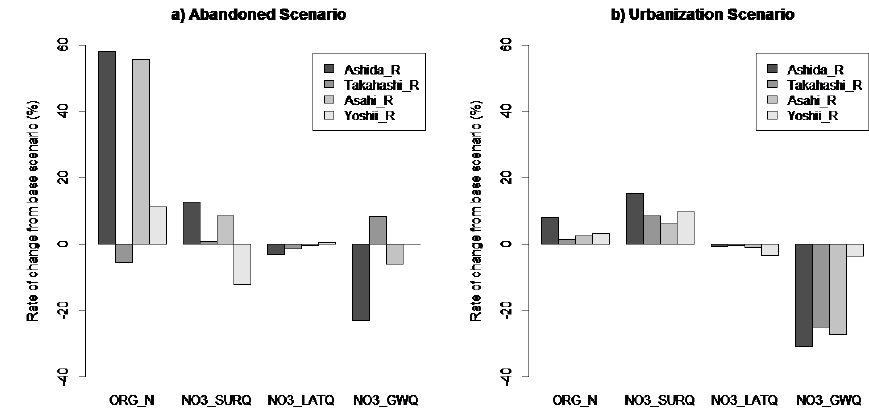
Figure 4. Rate of change in nitrogen discharge in different pathways. (a) Abandoned scenario, (b) urbanization scenario.